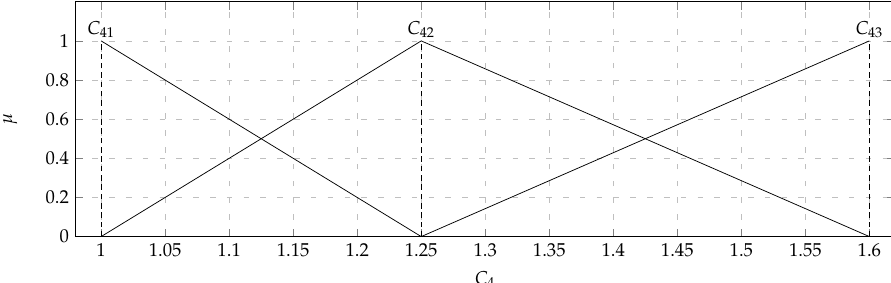
Figure 9. Visualization of the number of kills divided by number of deaths (K/D) Ratio ( C 4 ) and